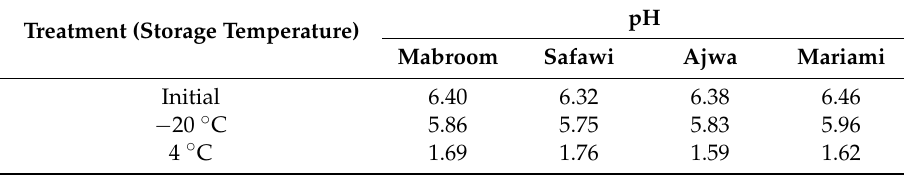
Table A1. The pH of different P. dactylifera cultivars methanolic extracts after 5 weeks of storage at different